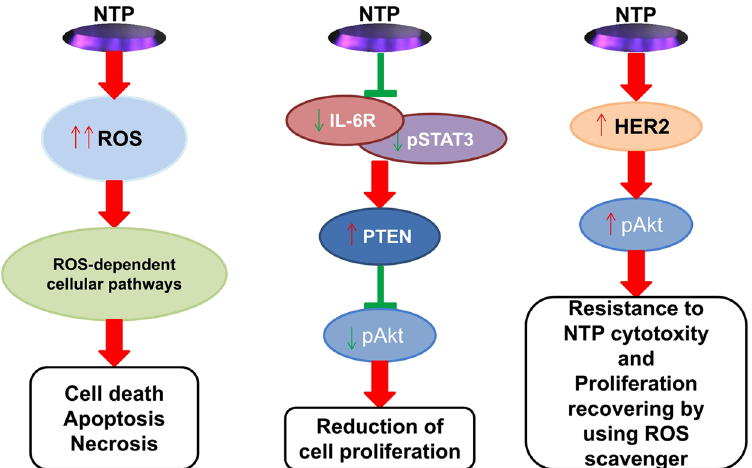
Figure 7. A general survey of NTP treatment affection on triple-negative breast carcinoma and normal cells through different cellular pathways.( A ) NTP treatment inhibits proliferation of MDA-MB-453 and MCF10A cells through ROS-dependent cellular pathway (not discussed in this article). ( B ) NTP treatment effects on reduction of proliferation through IL-6R/pSTAT3 pathway in MDA-MB-231 and MCF10A cells. ( C ) NTP treatment effects on recovering the proliferation especially in normal breast MCF10A cells with post-treated 5 mM